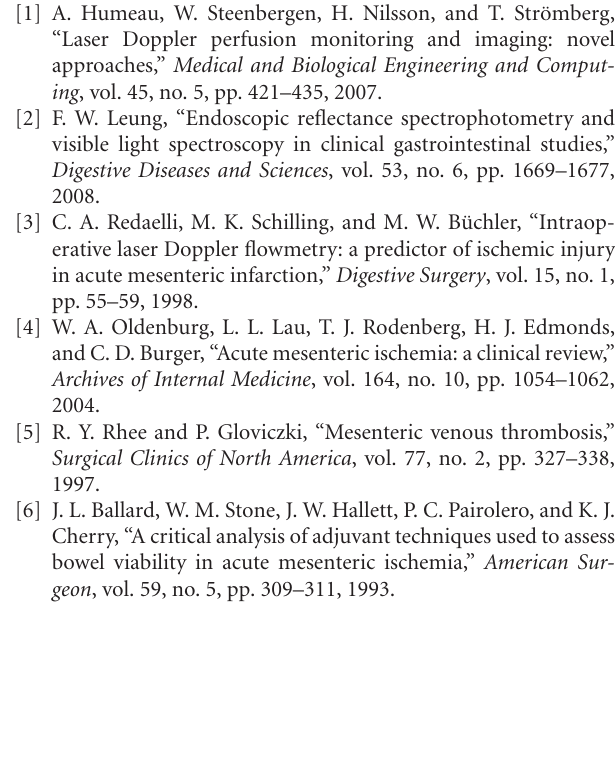
ileum, we defined the cut margin just before the recom- mended threshold values were reached as seen in Figure 2. The viable colon was used for reference